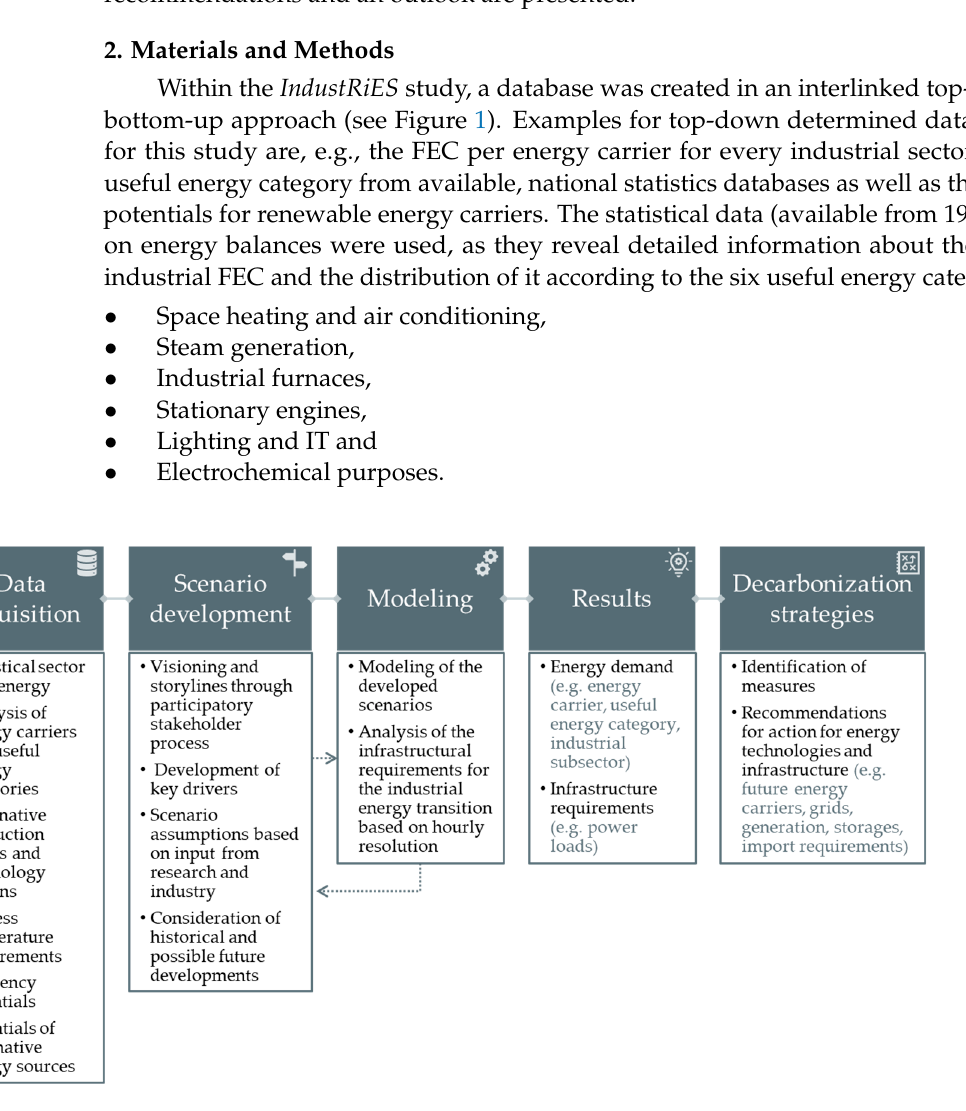
Figure 1. Visualization of the methodical approach used for this paper.